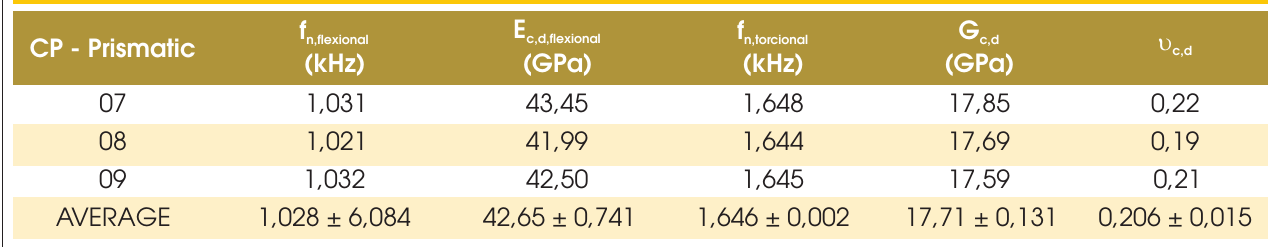
Table 10 – Other results of dynamic testing of prismatic